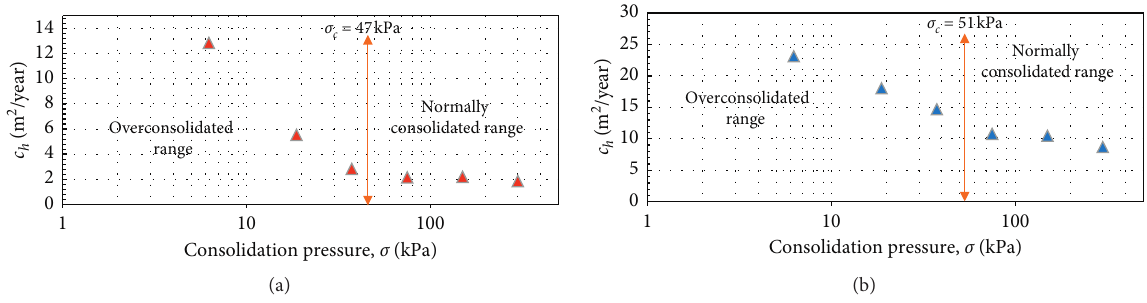
Figure 6: (a) The variation of c h with consolidation pressure (clay sample, depth: 2m—Site 2). (b) The variation of c h with consolidation pressure (sandy clay, depth: 6m—Site 5).